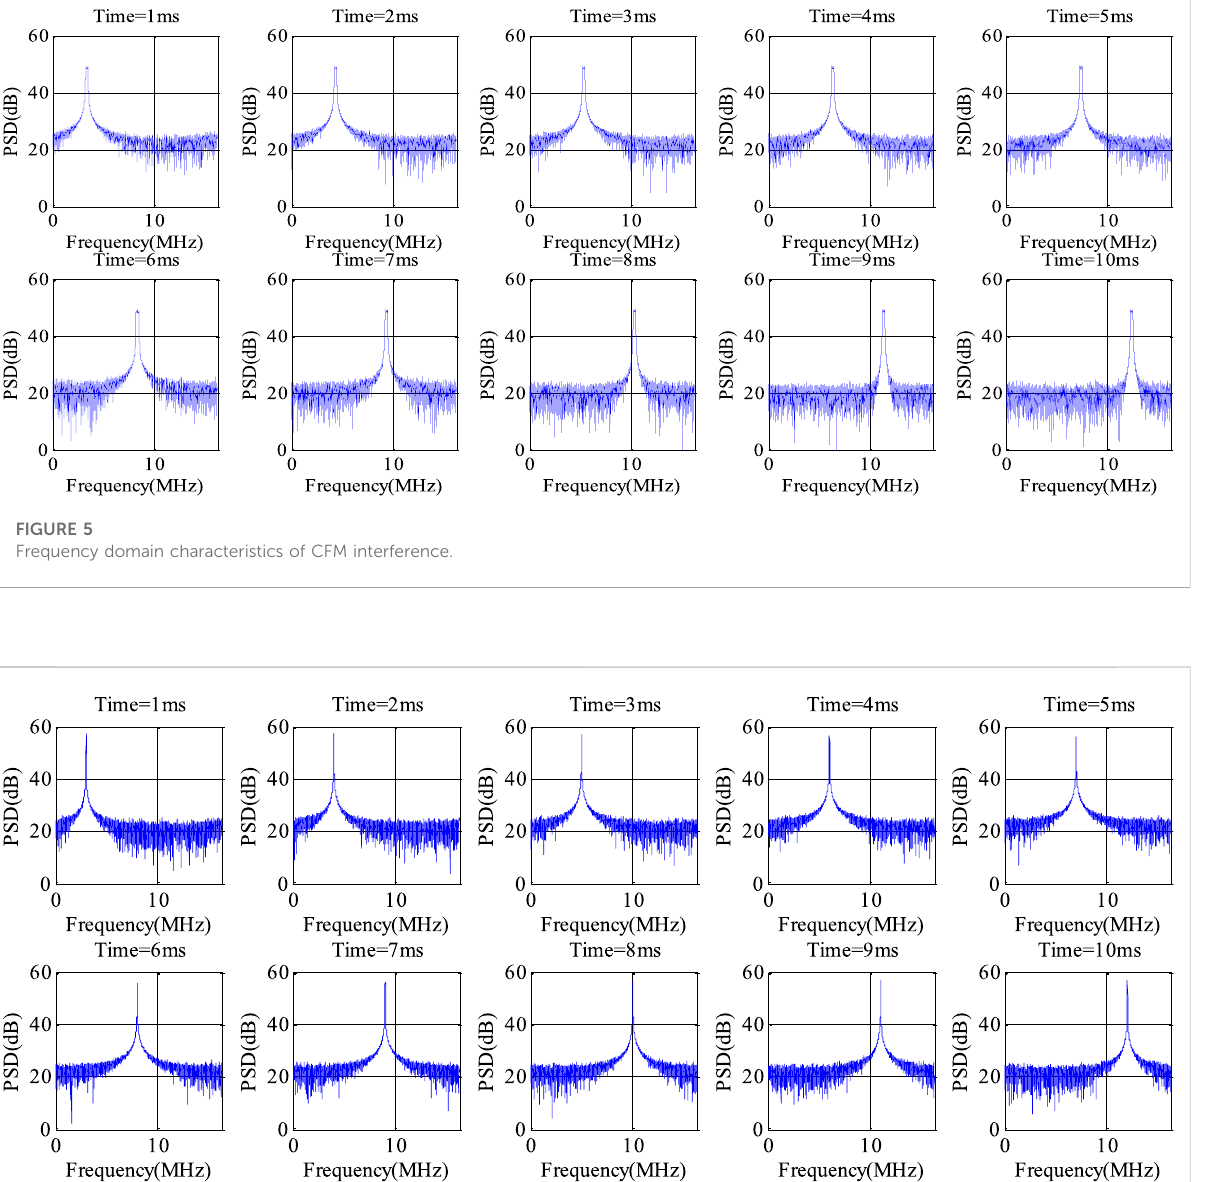
FIGURE 6 Frequency domain characteristics of DFM